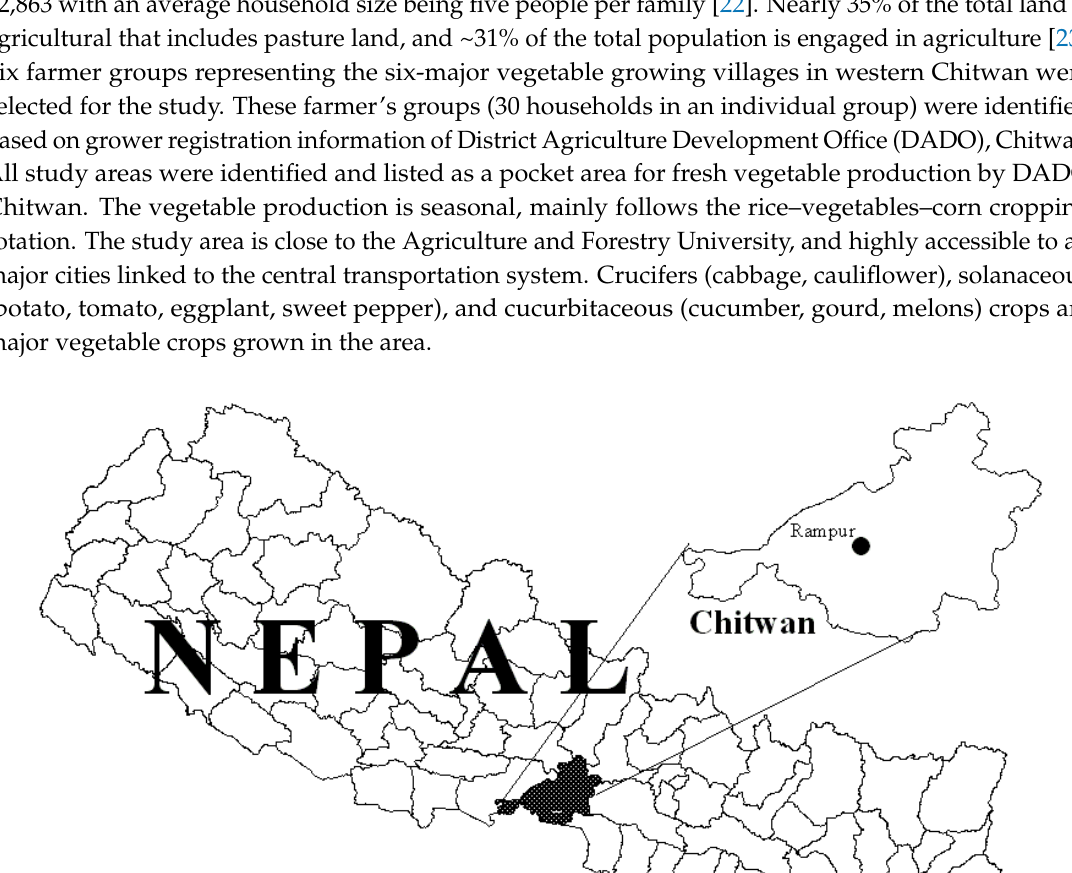
Figure 1. Study sites representing a major vegetable production pocket in Nepal.